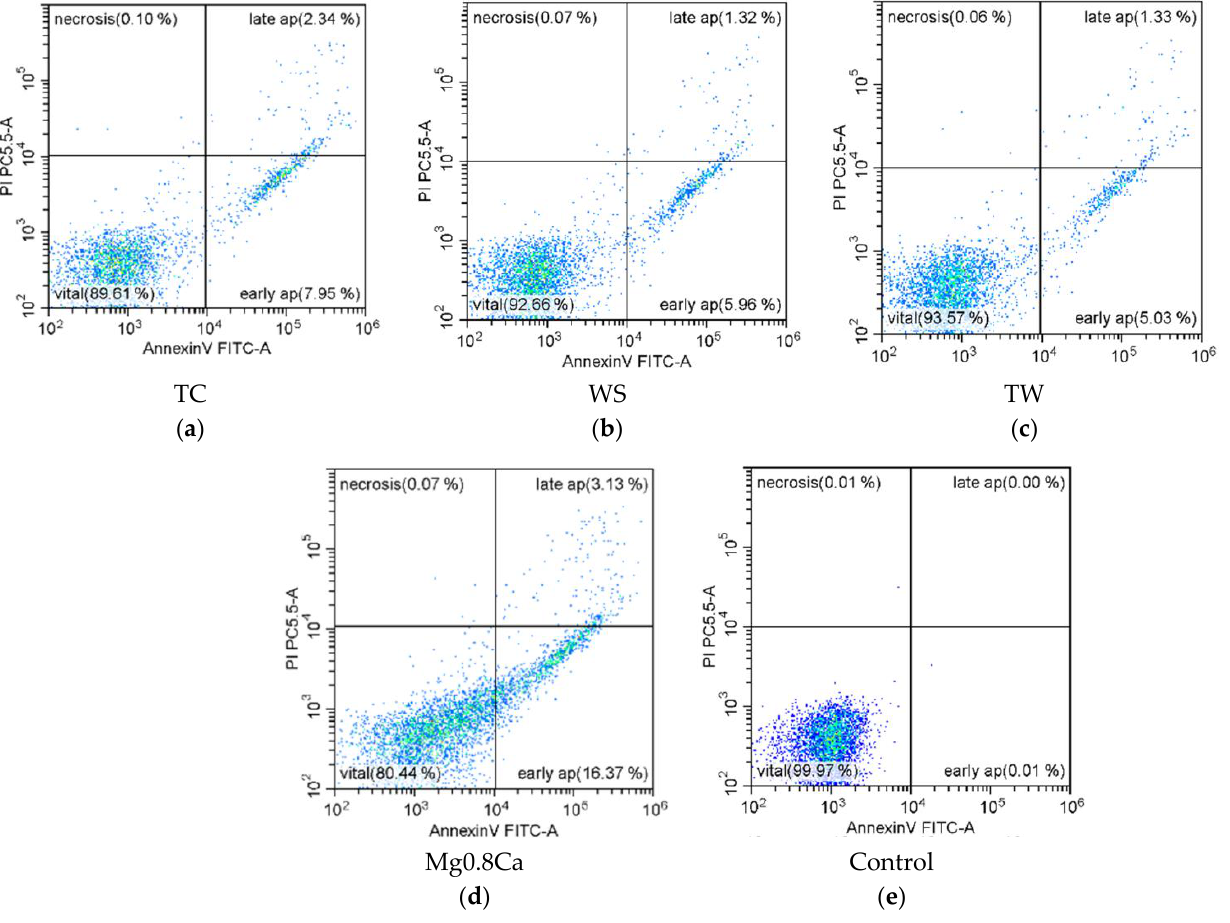
After 24-h incubation, the extract of uncoated pure Mg0.8Ca alloy (Figure 18d) caused visible changes in the viability of the 3T3 cell line compared to the control (Figure 18e). The number of living cells was 80.65% for the alloy and 99.95% for the control. The extract of the alloy induced apoptosis in cells. For example, the total population at the stage of early apoptosis (Q3) and late apoptosis (Q2) in cells treated with the extract of Mg0.8Ca was 16.4% and 3.1%, respectively. The viability of NIH/3T3 cells decreased to 87%. Thus, products that reduce the viability of cells were formed in the process of bio- degradation of the Mg0.8Ca alloy samples.